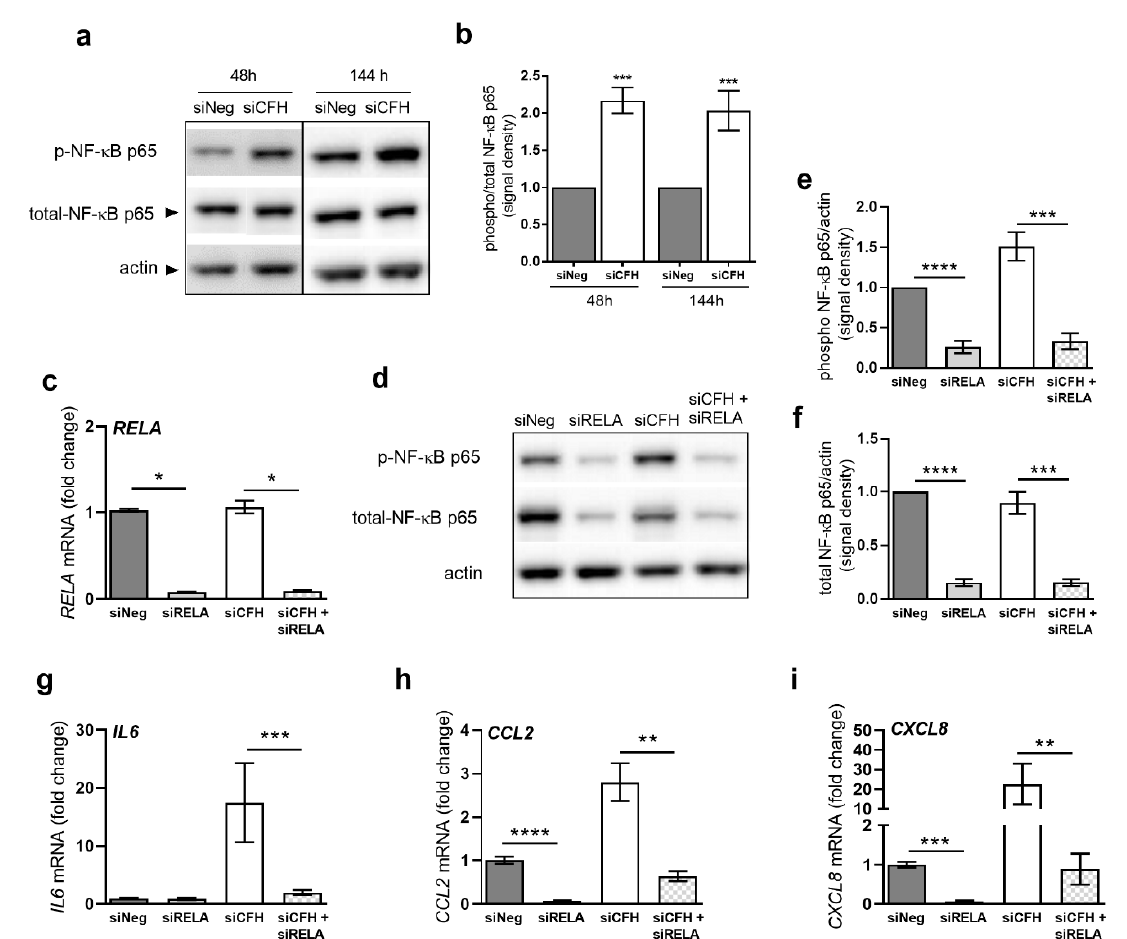
Figure 2. RPE cells deprived of FH show NF- κ B activation, and blocking NF- κ B abolishes the effects of FH loss on cytokine gene expression levels. a Western blot analyses of phosphorylated and total levels of NF- κ B p65 subunit in cell lysates of hTERT-RPE1 cells after 48h and144h. Total actin was used as a loading control. ( b ) Quantification of the signal density, normalized to actin, of at least four independent experiments as reported in ( a ) Bars indicate the signal density ratio between levels of phosphorylated and total NF- κ B p65 subunit. ( c ) Evaluation of RELA gene expression levels by qRT-PCR analyses in hTERT-RPE1 cells after 48h. Data are normalized to the housekeeping gene PRPL0 using ∆ ∆ Ct methods. SEM is shown, n = 5. ( d ) Western blot analyses of phosphorylated and total levels of NF- κ B p65 subunit in cell lysates of hTERT-RPE1 cells after 48 h. Total actin was used as a loading control. ( e ) Quantification of the signal density of three independent experiments in the conditions reported in ( c , d ). Bars indicate the signal density ratio between the phosphorylated NF- κ B p65 subunit and actin. ( f ) Quantification of the signal density of three independent experiments in the conditions reported in c-d. Bars indicate the signal density ratio between the total NF- κ B p65 subunit and actin. ( g , h , i ) Gene expression analyses by qRT-PCR of hTERT-RPE1 cells in the conditions reported in c-d: ( g ) interleukin-6 ( IL6 ), ( h ) C-C Motif Chemokine Ligand 2 ( CCL2 ), and ( i ) interleukin-8 ( CXCL8 ). Data are normalized to housekeeping gene PRLP0 using ∆ ∆ Ct method. SEM is shown, n = 3 − 5. Western blot images were cropped, and full-length blots are provided in Supplementary Material. Significance was assessed by a Student’s t-test. * p < 0.05, ** p < 0.01, *** p < 0.001, **** p < 0.0001. negative control (siNeg), CFH specific siRNA (siCFH), RELA specific siRNA (siRELA).